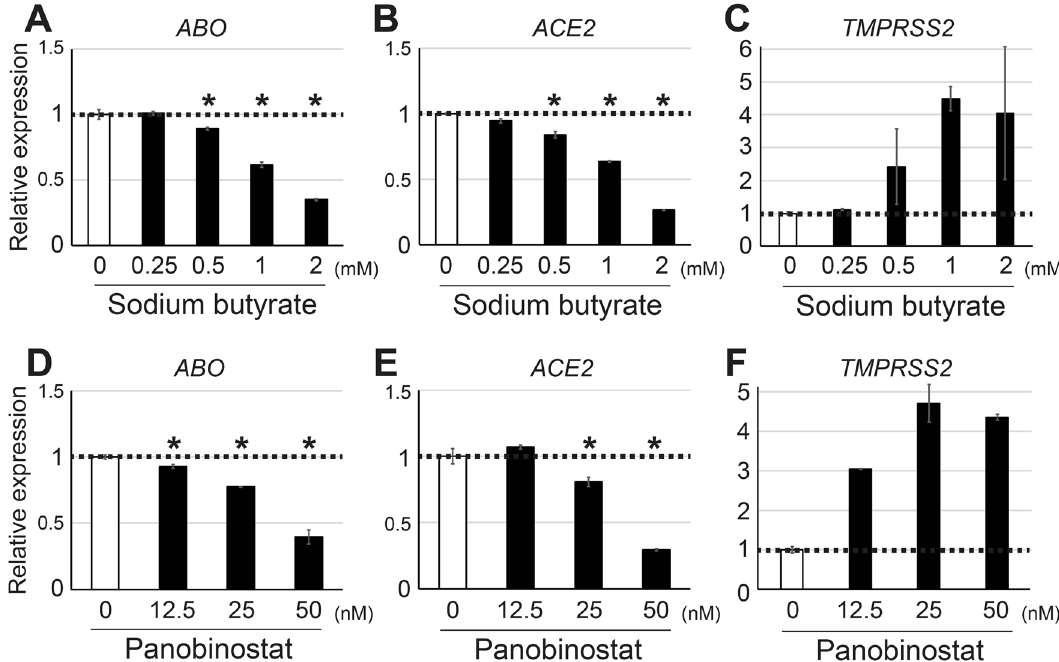
Figure 3. Suppression of ABO and ACE2 in NUGC-4 cells treated with sodium butyrate or panobinostat for 24 h. ( A – C ) Relative amounts of ABO ( A ), ACE2 ( B ) and TMPRSS2 ( C ) transcripts in NUGC-4 cells treated with various concentrations of sodium butyrate for 24 h. ( D – F ) Relative amounts of ABO ( D ), ACE2 ( E ) and TMPRSS2 ( F ) transcripts in NUGC-4 cells treated with various concentrations of panobinostat for 24 h. The transcript amounts are expressed as mean fold values relative to those without HDACI. The asterisks represent a significant reduction compared to the untreated values ( p <